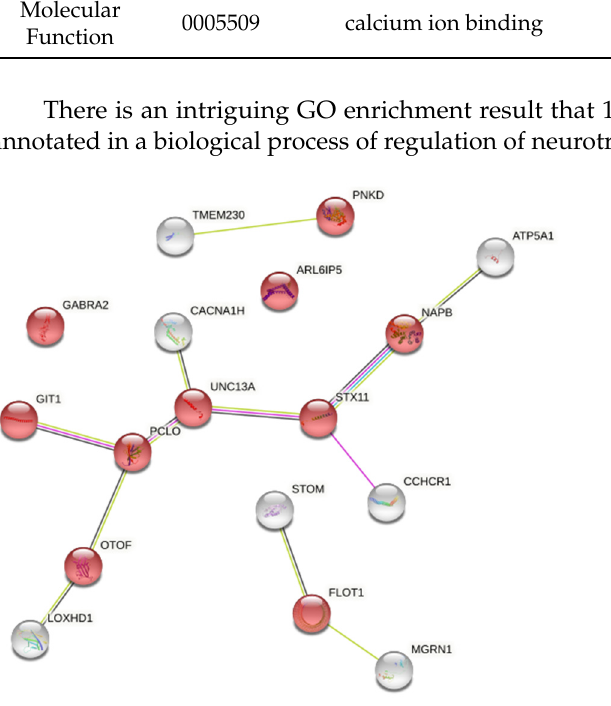
Figure 3. The ten proteins represented by red nodes were enriched in the biological process category of “neurotransmitter level enrichment regulation”. (The input genes were 140 methylated differential genes based on the differential methylation probe method). The abbreviations in the figure is input protein name and network nodes represent proteins and the splice isoforms or post-translational modifications are collapsed, i.e., each node represents all the proteins produced by a single, protein- coding gene locus. The white nodes represent the input proteins that interact with the red